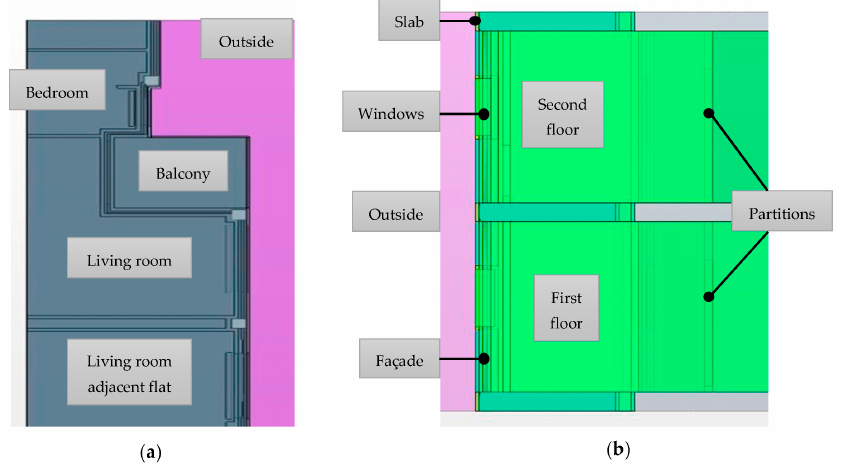
Figure 3. House model. ( a ) Floor section; ( b ) Construction section through facade.